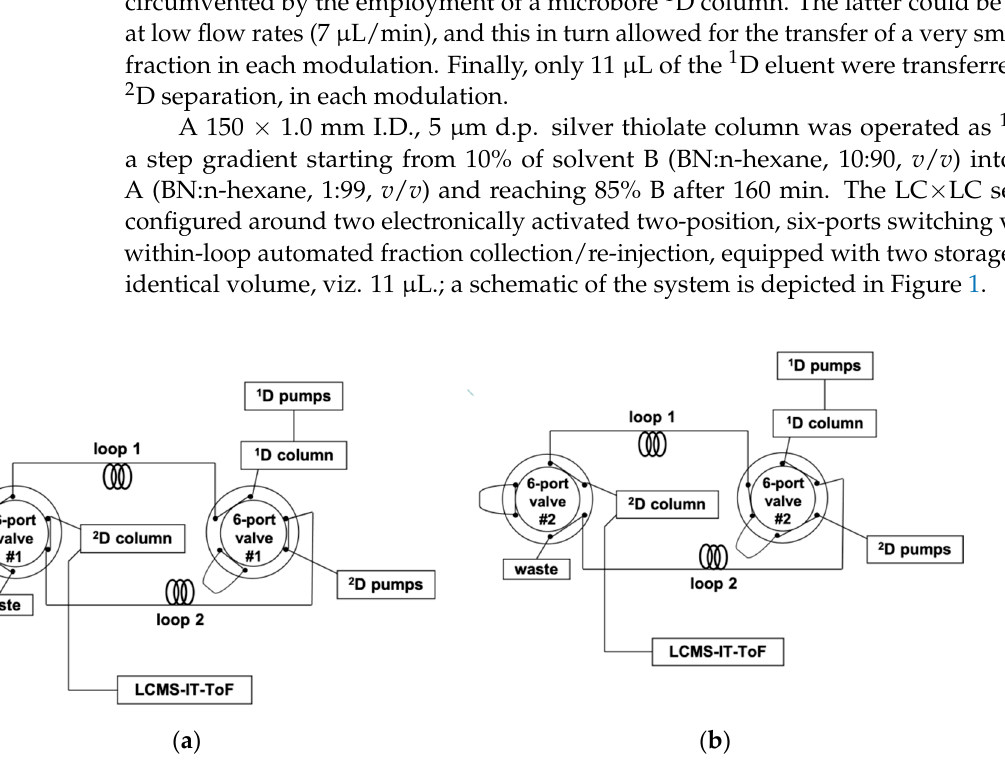
Table 1. Intra- and inter-day variabilities for TAGs retention times (15 injections).